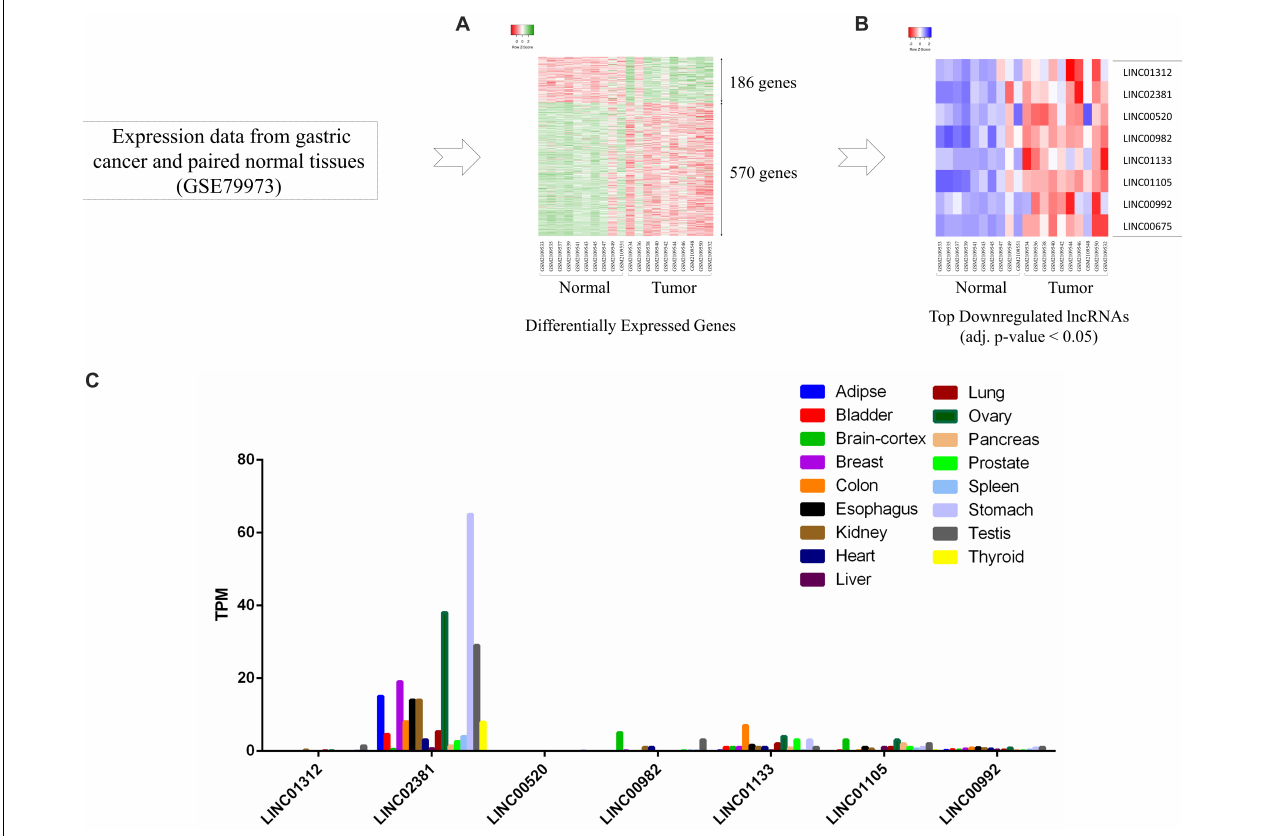
FIGURE 1 | LINC02381 as a differentially expressed lncRNA in gastric. (A) Heatmap of differentially expressed genes; 756 genes were differentially expressed in gastric cancer according to logFC > 2 or < − 2. (B) The top eihgt downregulated lncRNAs (adj. p -value < 0.05) were shown in a heatmap. (C) Expression of the downregulated lncRNAs across different human normal tissues adopted from GTEx database. LINC02381 has a higher basal expression than other lncRNAs and also has a distinct expression in gastric tissue compared to other